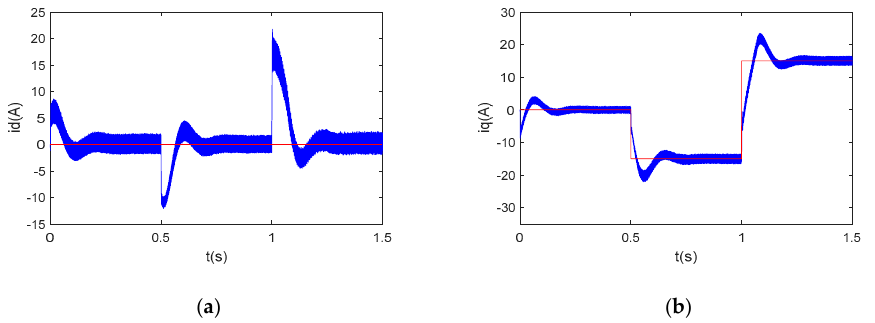
12,000 rpm. ( a ) d-axis current; ( b ) q-axis current.